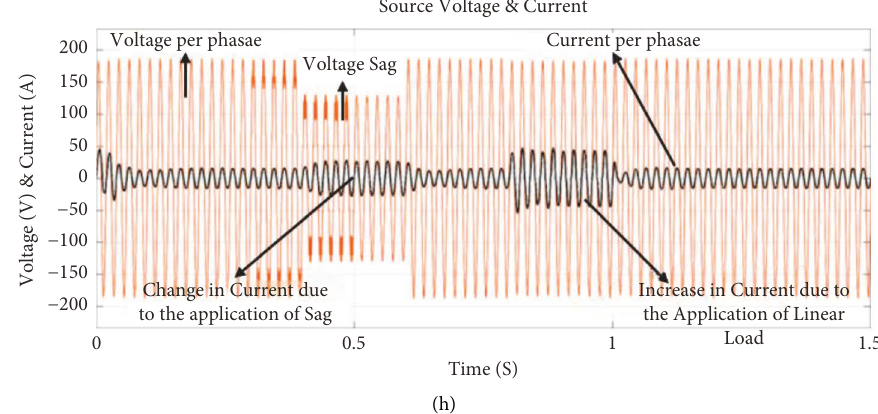
Figure 6: (a) Source voltage and current, (b)3rd and 11th order voltage harmonics, (c)source voltage with sag, (d)compensated voltage, (e) uncompensated voltage, (f)uncompensated current, (g)compensated current, and (h)per phase source voltage and